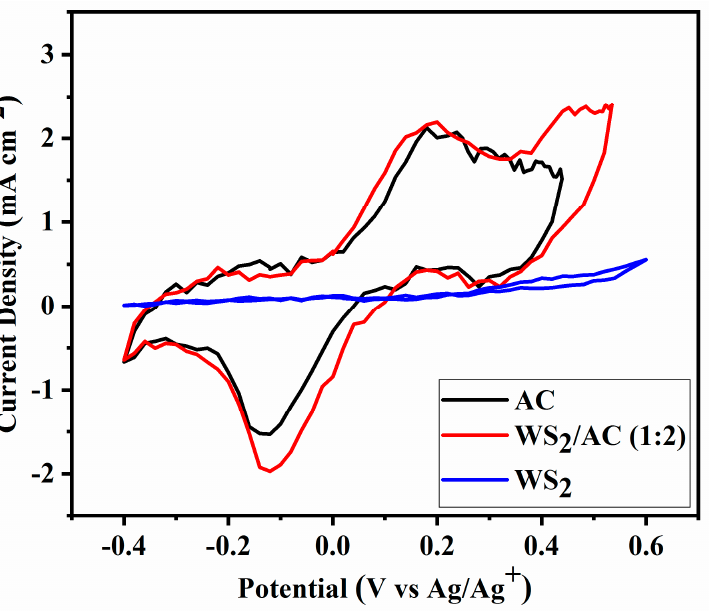
Figure 5. The cyclic voltammetry of the DSSCs is assembled with different counter electrodes (WS 2 , AC, and WS 2 /AC).